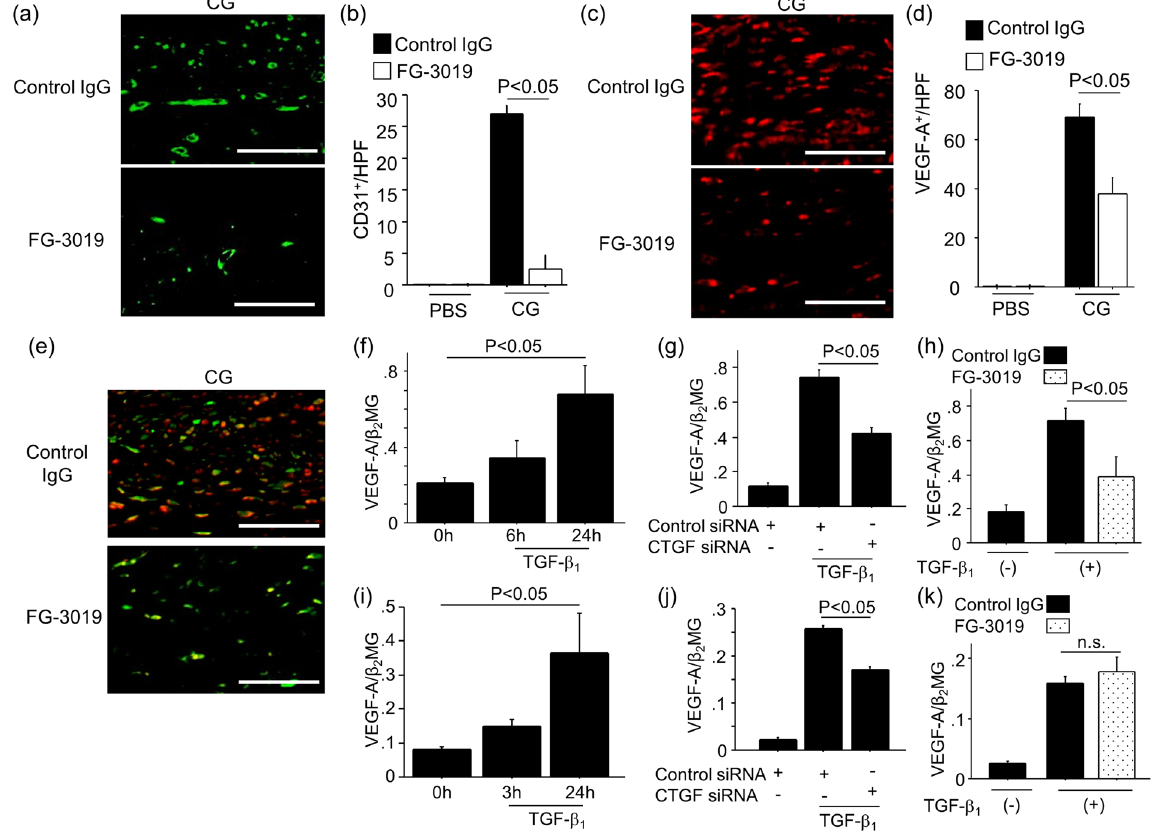
Figure 8. CG-induced peritoneal angiogenesis and VEGF-A expression required CTGF. ( a ) The localization of CD31 + vessels in fibrotic peritoneum. Peritoneal sections at day 21 were obtained from mice treated with control IgG or FG-3019. Representative tissue sections stained with anti-CD31 antibody are shown. Bars, 50 μ m. ( b ) Numbers of CD31 + vessels in the peritoneum are expressed as the mean number ± SEM per HPF (n = 5 mice/group). ( c ) Immunostainings of VEGF-A + cells in fibrotic peritoneum at day 21. Representative tissue sections stained with anti-VEGF-A antibody are shown. Bars, 50 μ m. ( d ) Numbers of VEGF-A + vessels in the peritoneum are expressed as the mean number ± SEM per HPF (n = 5 mice/group). ( e ) Representative tissue sections of dual-immunostainings of GFP (green) and VEGF-A (red) at 21 days. Bars, 50 μ m. ( f ) VEGF-A expression in PMCs stimulated with 5 ng/ml TGF- β 1 . ( g ) VEGF-A expression in PMCs. PMCs were transfected with control siRNA or CTGF siRNA, and then stimulated with TGF- β 1 (5 ng/ml for 24 hrs). ( h ) VEGF-A expression in PMCs. PMCs were preincubated with FG-3019 (10 μ g/ml) or control IgG (10 μ g/ml) for 1 h, and then stimulated with TGF- β 1 (5 ng/ml for 24 hrs). ( i ) VEGF-A expression in NIH3T3 cells stimulated with 5 ng/ ml TGF- β 1 . ( j ) VEGF-A expression in NIH3T3 cells. NIH3T3 cells were transfected with control siRNA or CTGF siRNA, and then stimulated with TGF- β 1 (5 ng/ml for 24 hrs). ( k ) NIH3T3 cells were preincubated with FG-3019 (10 μ g/ml) or control IgG (10 μ g/ml) for 1 h, and then stimulated with TGF- β 1 (5 ng/ml for 24